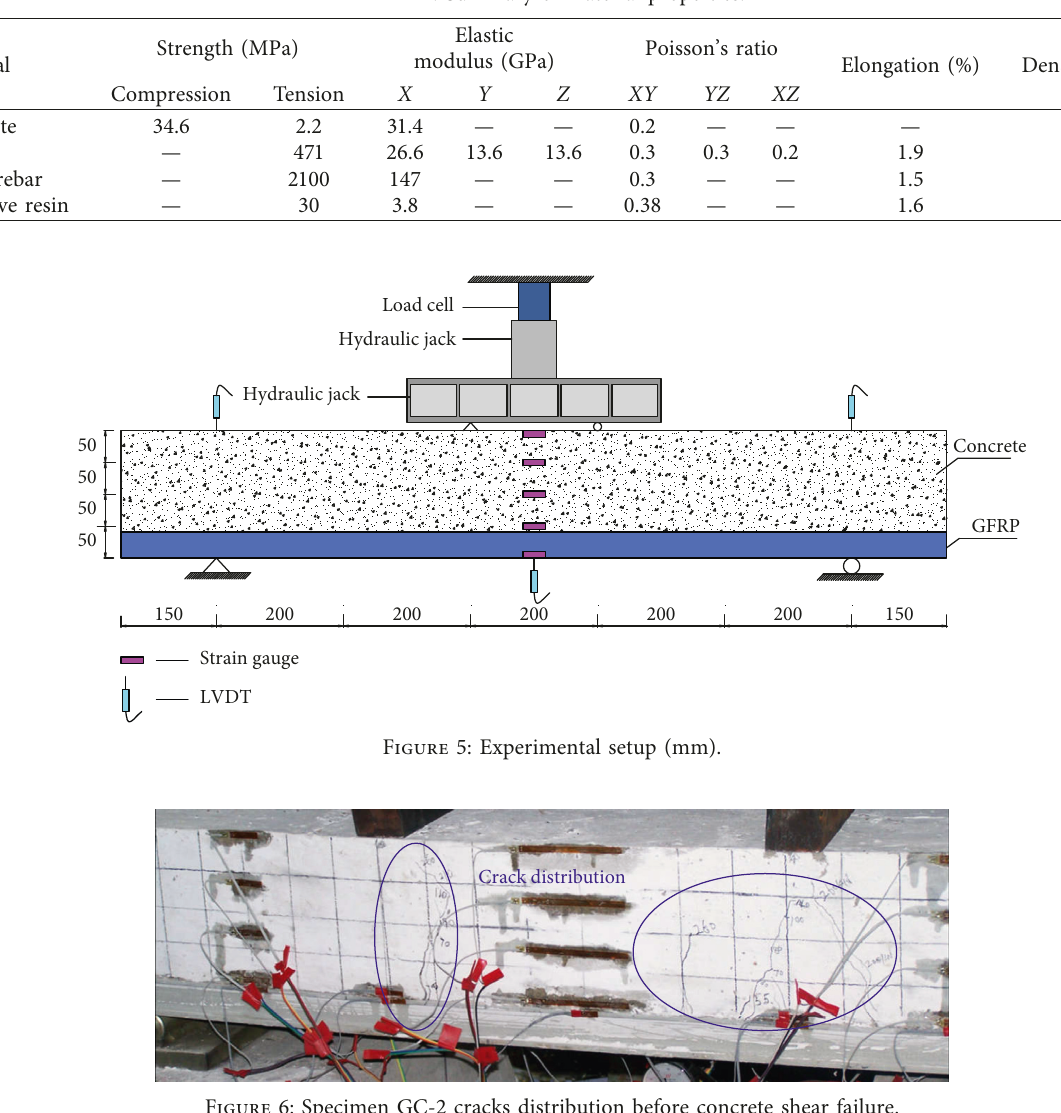
Figure 6: Specimen GC-2 cracks distribution before concrete shear failure.